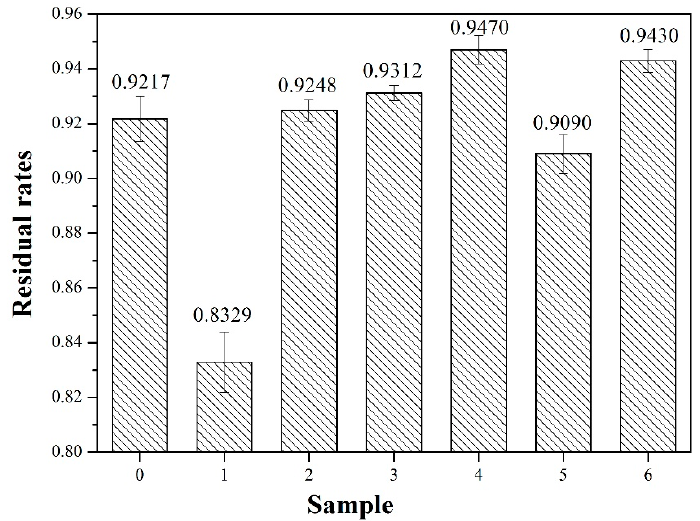
Figure 2. Residual rates of different adhesive samples: 0 (12 wt% soy protein isolate (SPI)), 1 (18 wt% SPI/bromelain), 2 (18 wt% SPI/bromelain/3 wt% TGA), 3 (18 wt% SPI/bromelain/6 wt% TGA), 4 (18 wt% SPI/bromelain/9 wt% TGA), 5 (18 wt% SPI/bromelain/12 wt% TGA), and 6 (18 wt% SPI/9 wt% TGA).